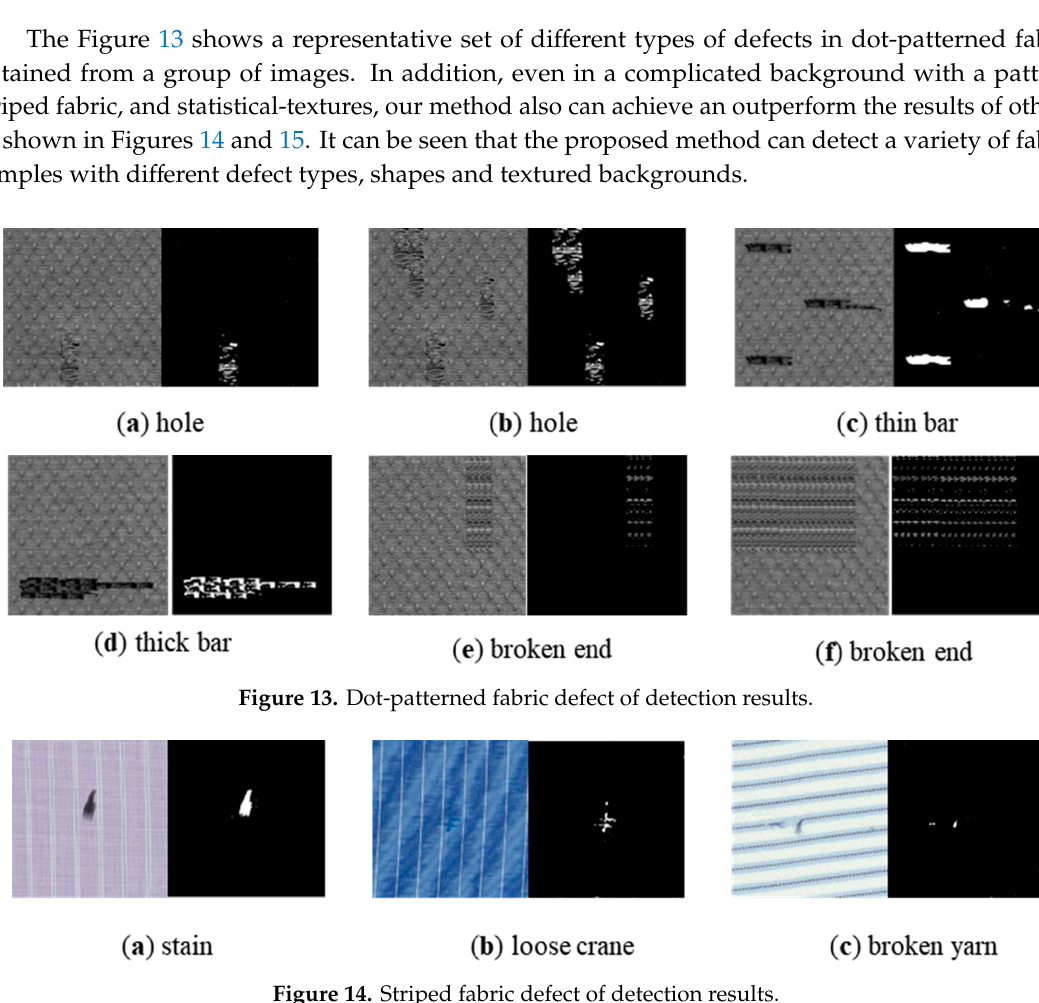
Figure 12. Box-patterned fabric defect of detection results.